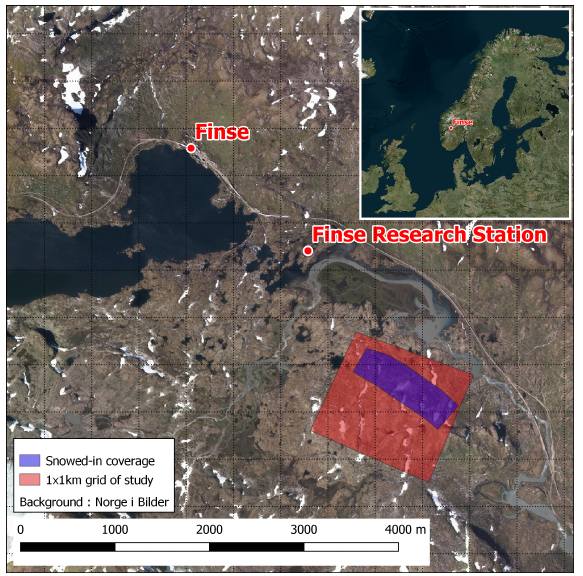
Figure 6. Map of the snow field used for this study with the picked GCPs and the validation dGNSS